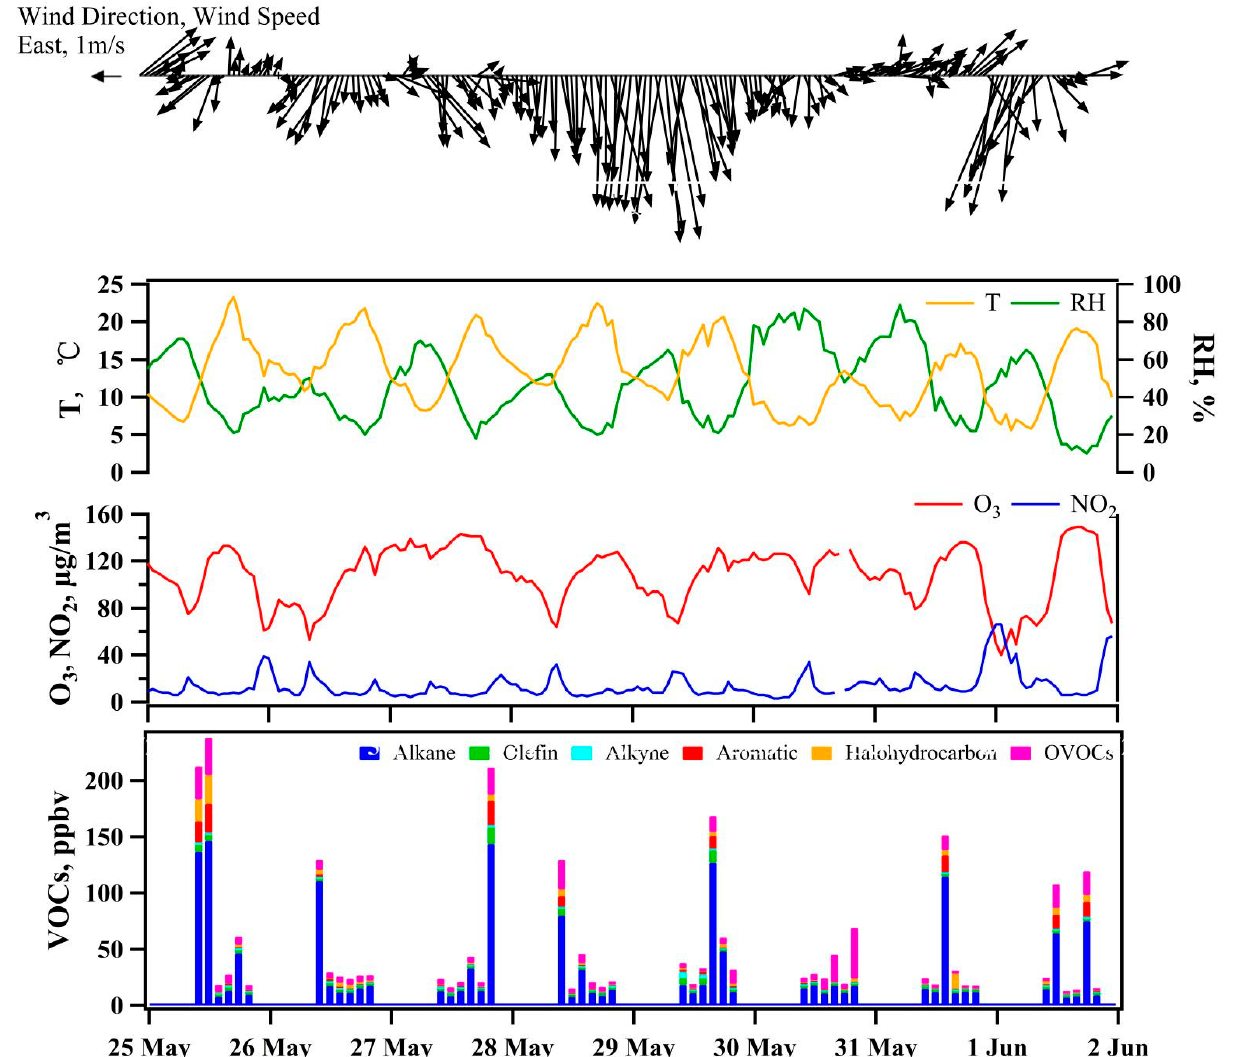
Figure 2. During the observation period, there were profiles of wind speed, wind direction, humidity, temperature, ozone, NO 2 , and VOCs. The sampling times were 9:00, 11:00, 13:00, 15:00, 17:00, and 19:00 every day; each bar represents the chemical composition of one sample.